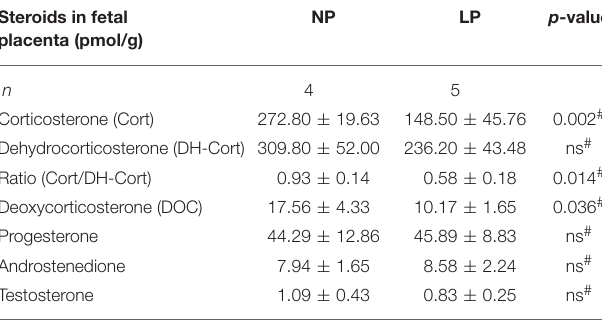
TABLE 7 | Steroid analysis of placenta. Steroids in fetal placenta